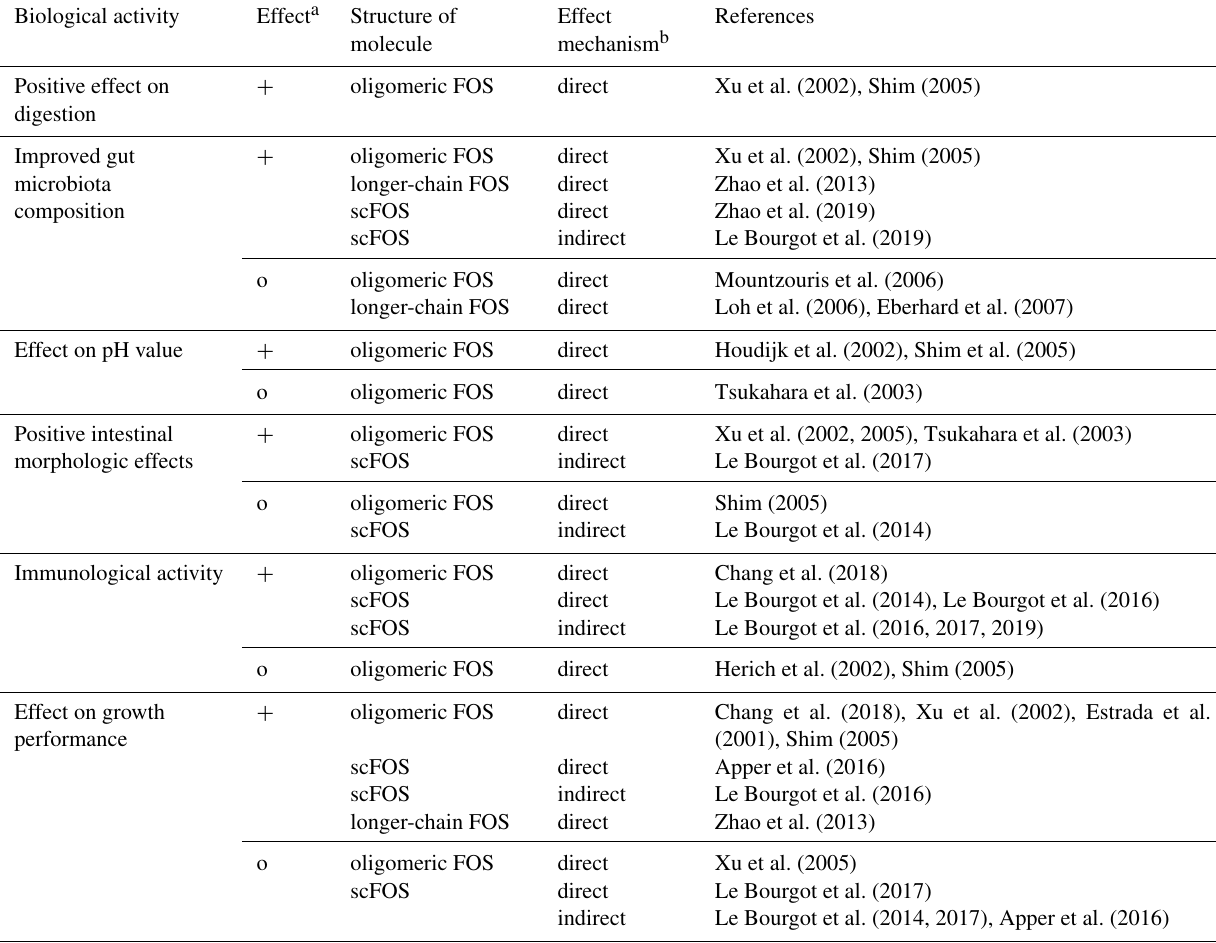
Table 1. Effects of fructooligosaccharides (FOSs) in different chemical structures on reviewed